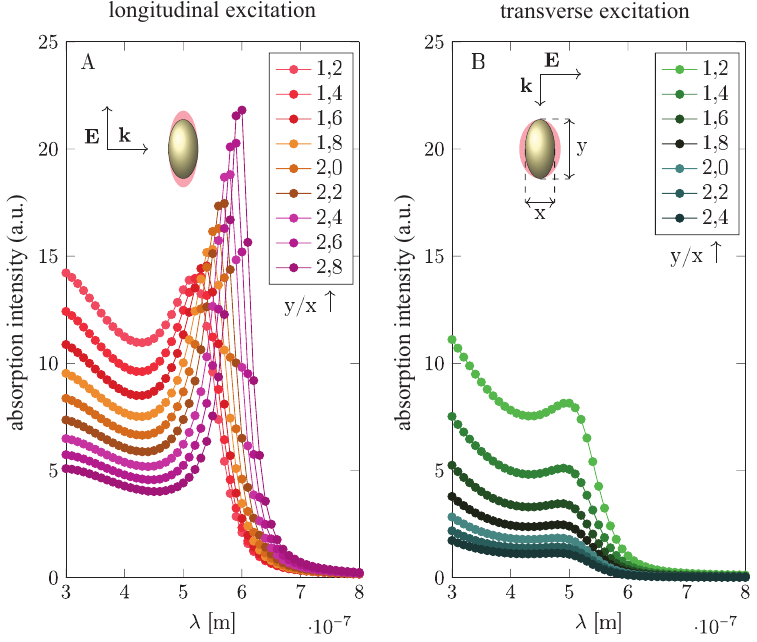
Figure 7. Plasmon double resonance in elongate metallic nanoparticle. (left) The resonance for dipole Figure 9. Plasmon double resonance in elongated metallic nanoparticles. ( left ) The resonance for oscillations along the longer axis. (right) The resonance for oscillations along the shorter axis – the dipole oscillations is depicted along the longer axis. ( right ) The resonance for oscillations is depicted frequency difference between both polarizations grows with the aspect ratio increase [44] (Comsol along the shorter axis—the frequency difference between both polarizations increases as the aspect simulation). ratio increases [45] (Comsol